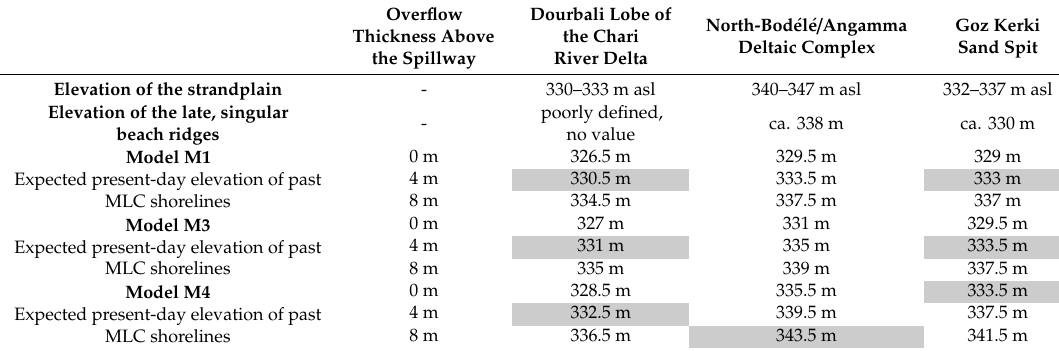
Table 3. Elevations of the paleo-shorelines of Megalake Chad at three key-areas and expected present-day shoreline elevation according to the Earth models and accounting for three di ff erent overflow thickness above the Mayo Kebbi spillway. The ca. 0.5–1 m correction related to the resulting additional water load is here neglected (see Figure 4). Grey cells correspond to reconstructed elevations within the range of measured paleo-shoreline